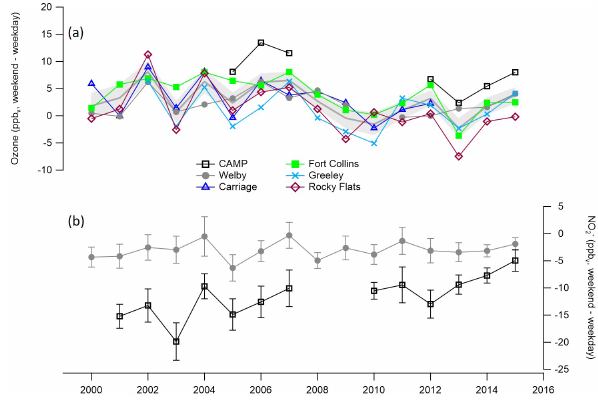
Figure 7. (a) The change in O 3 calculated as average weekend (Sunday) minus weekday (Wednesday) O 3 for the six NFRMA sites identified by color and marker. The solid grey line is the average of the sites. The inclusion of a site in the averaging for a given year was dependent on available data for that year. The light-grey shad- ing represents ± the 95% confidence interval of all Wednesday and Sunday hourly values for each year for sites with available data. (b) The change in NO ∗ is calculated identically to O 3 in (a) for 2 the CAMP and Welby sites, and the error bars represent the 95% confidence interval of the